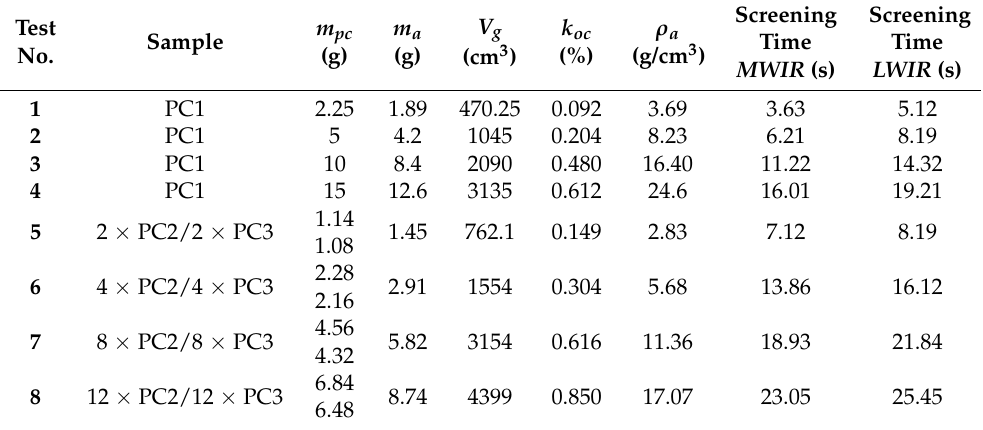
Table 3. Smoke chamber test results.